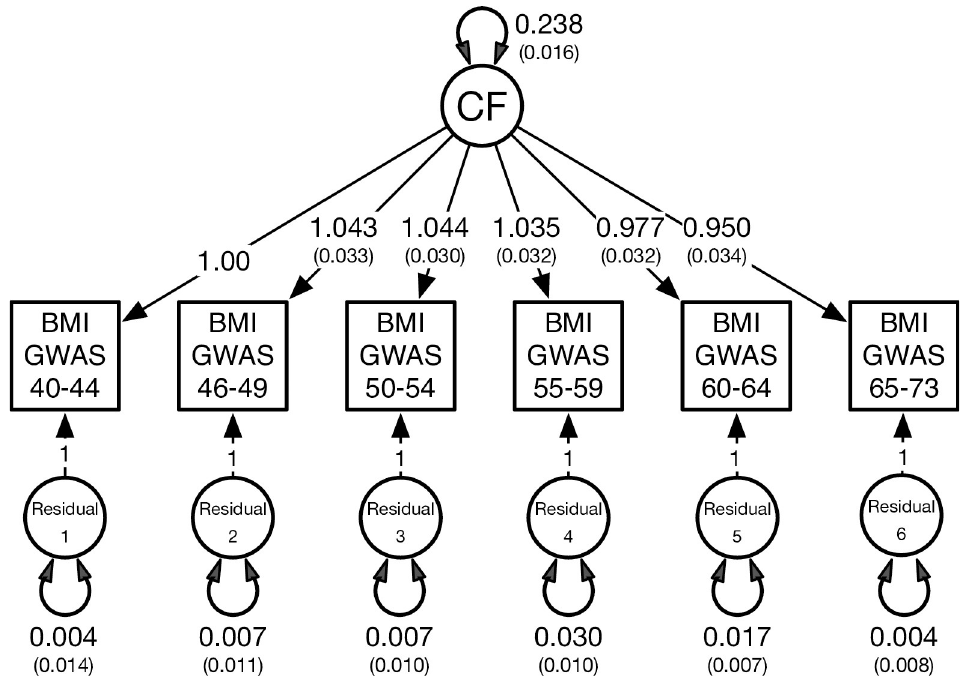
Fig 2. Best fitting factor analytic model with a single common factor (CF) based on the combined male and female data. The CF explains covariation between the six GWAS summary statistics each based on five-year intervals between ages 40–73 years. To identify this model, the first factor loading from the CF to BMI GWAS at 40–45 years was constrained to one. The double-headed arrow on the CF denotes the standardized variance, or SNP-based heritability, for BMI. Double-headed arrows on the residuals denote genetic variation at each age interval not otherwise explained by the CF.